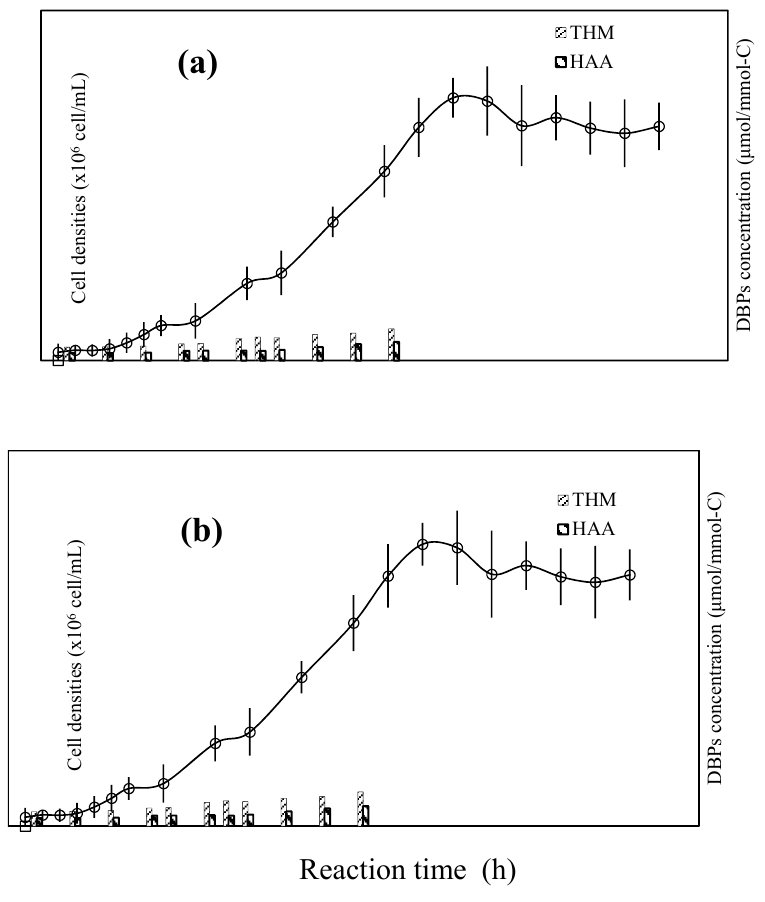
Figure 9. Formation potential of DBPs during all growth phases of cyanobacteria cultures. ( a ) Microcystis aeruginosa , ( b ) Oscillateria tenuisa .